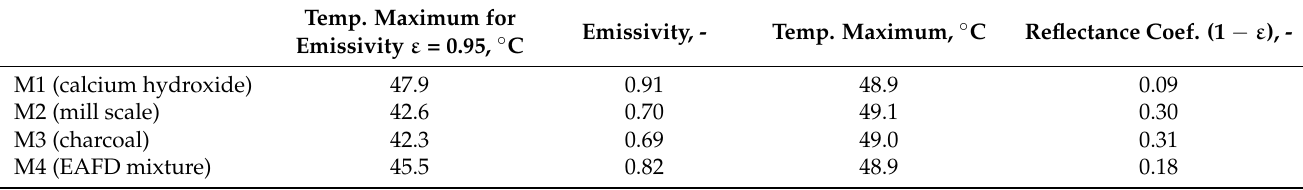
Table 1. Emissivity of briquettes from individual materials at 49 ◦ C ( ± 0.1 ◦ C). Temp. Maximum